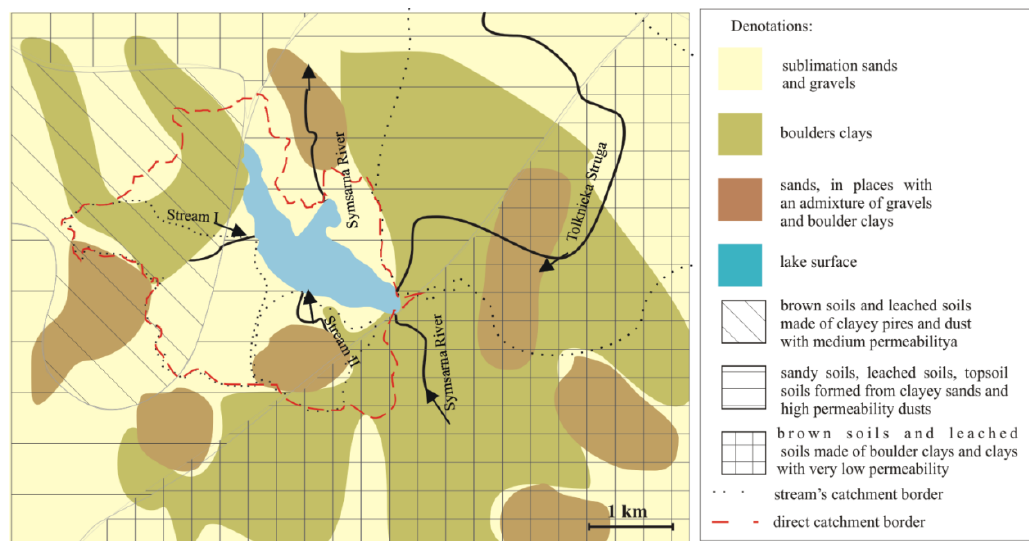
Figure 2. The distribution of geological formations and soils in the immediate drainage area of Lake Symsar and in the catchment basins of its tributaries.